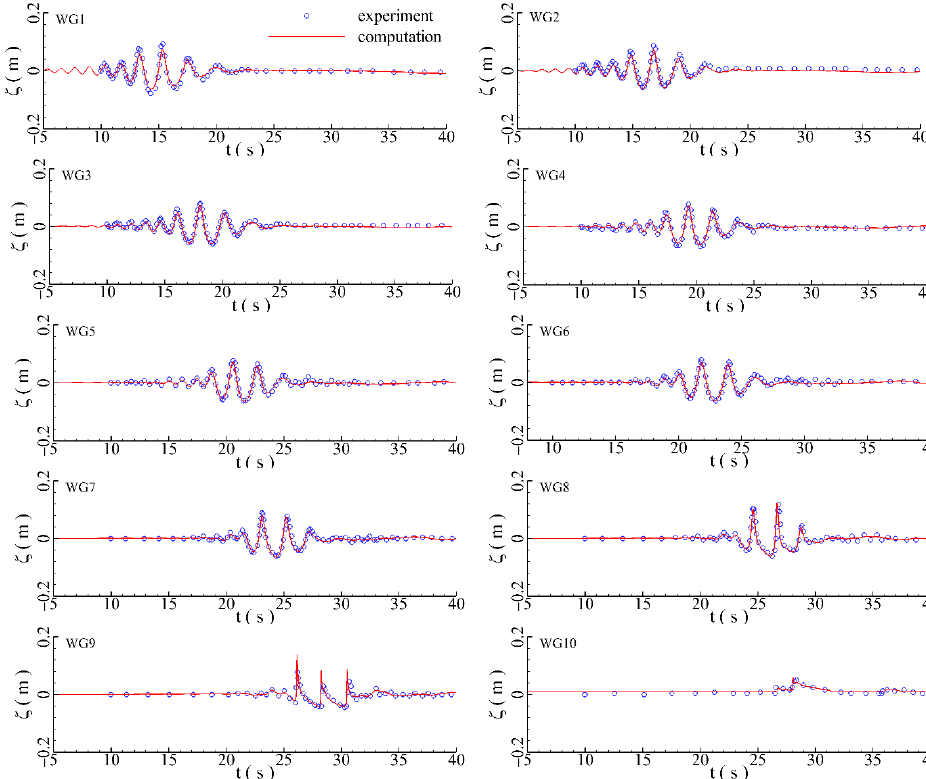
Figure 2. Water elevations recorded at different wave gauges.